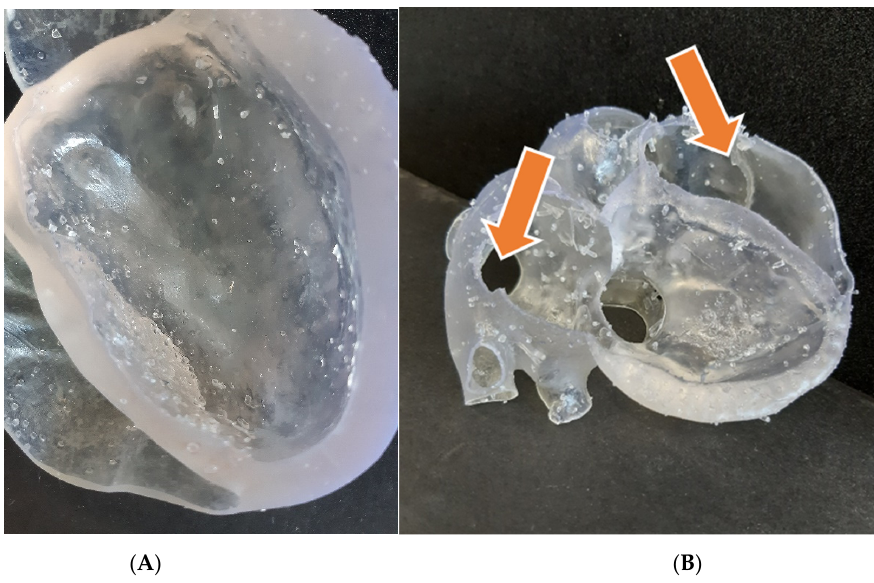
Figure 7. ( A ) Detail of the heart model (lower part) printed in flexible resin, in which residual touchpoints are clearly visible; ( B ) the corresponding upper part, broken in some points (see arrows) during support removal.